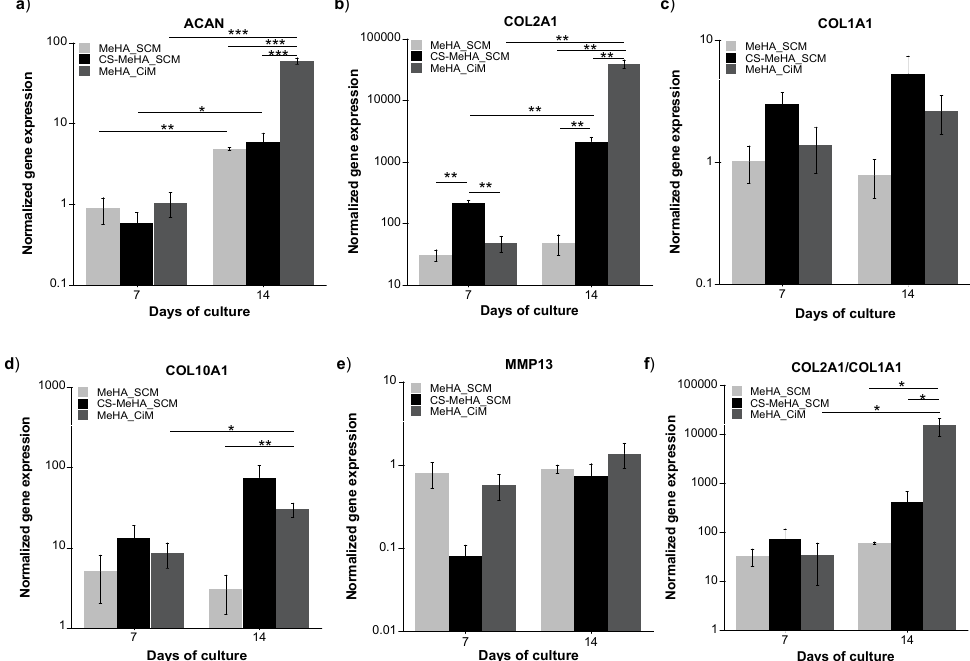
Figure 6. Gene expression analysis of ( a ) ACAN, ( b ) Col2A1, ( c ) Col1A1, ( d ) Col10A1, and ( e ) MMP13 for hMSCs encapsulated in MeHA hydrogels cultured in SCM or CiM and CS-MeHA hydrogels cultured in SCM, following 7 and 14 days of in vitro culture. ( f ) Col2A1 / Col1A1 ratio of gene expression. The data were normalized to GAPDH and expressed as fold di ff erence relative to undi ff erentiated hMSCs cultured on a TCPS. The results were analyzed using two-way analysis of variance (ANOVA) and are presented as mean values ± standard error of the mean, * p < 0.05, ** p < 0.01, *** p < 0.001 ( n = 3 for each donor, hMSCs derived from three di ff erent